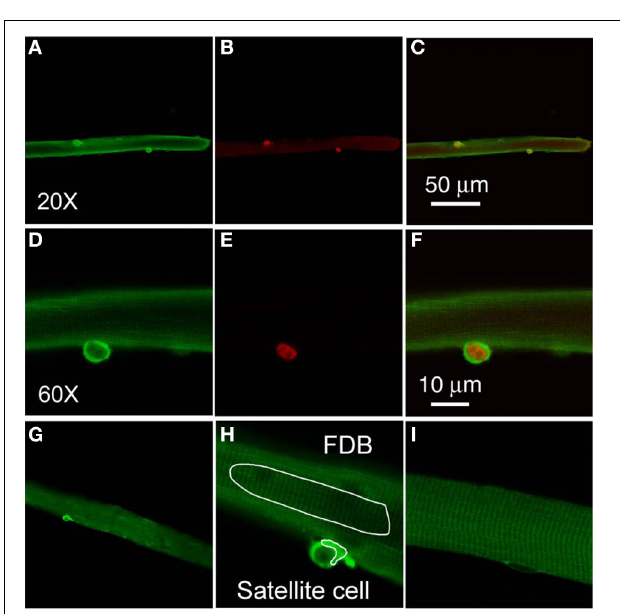
FIGURE 2 | Satellite cells exhibit a higher level expression of TRPC1. Freshly isolated FDB fibers were fixed and incubated with anti-TRPC1 and anti-Pax7 antibodies, followed by secondary antibodies conjugated with Alexa Fluor 488 or Alexa Fluor 647, respectively. Satellite cells have stronger stain with anti-TRPC1 antibody than the host FDB fibers (A,D) . Satellite cells were identified with anti-Pax7 immunostain (B,E) . TRPC1 is localized at both cytoplasm and nuclei of satellite cells (D) , whereas Pax7 is localized in the nuclei of satellite cells (E) . Overlays are shown in (C,F) . (D,E) are the same cell as (A,B) but with higher magnification. (G,H) are images demonstrating how the AOI s are defined in FDB fiber and in satellite cell. (I) shows a FDB fiber incubated with only secondary